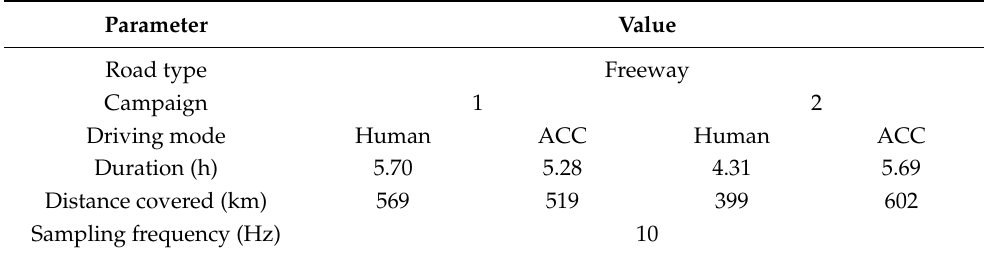
Table 2. Introduction of the OpenACC